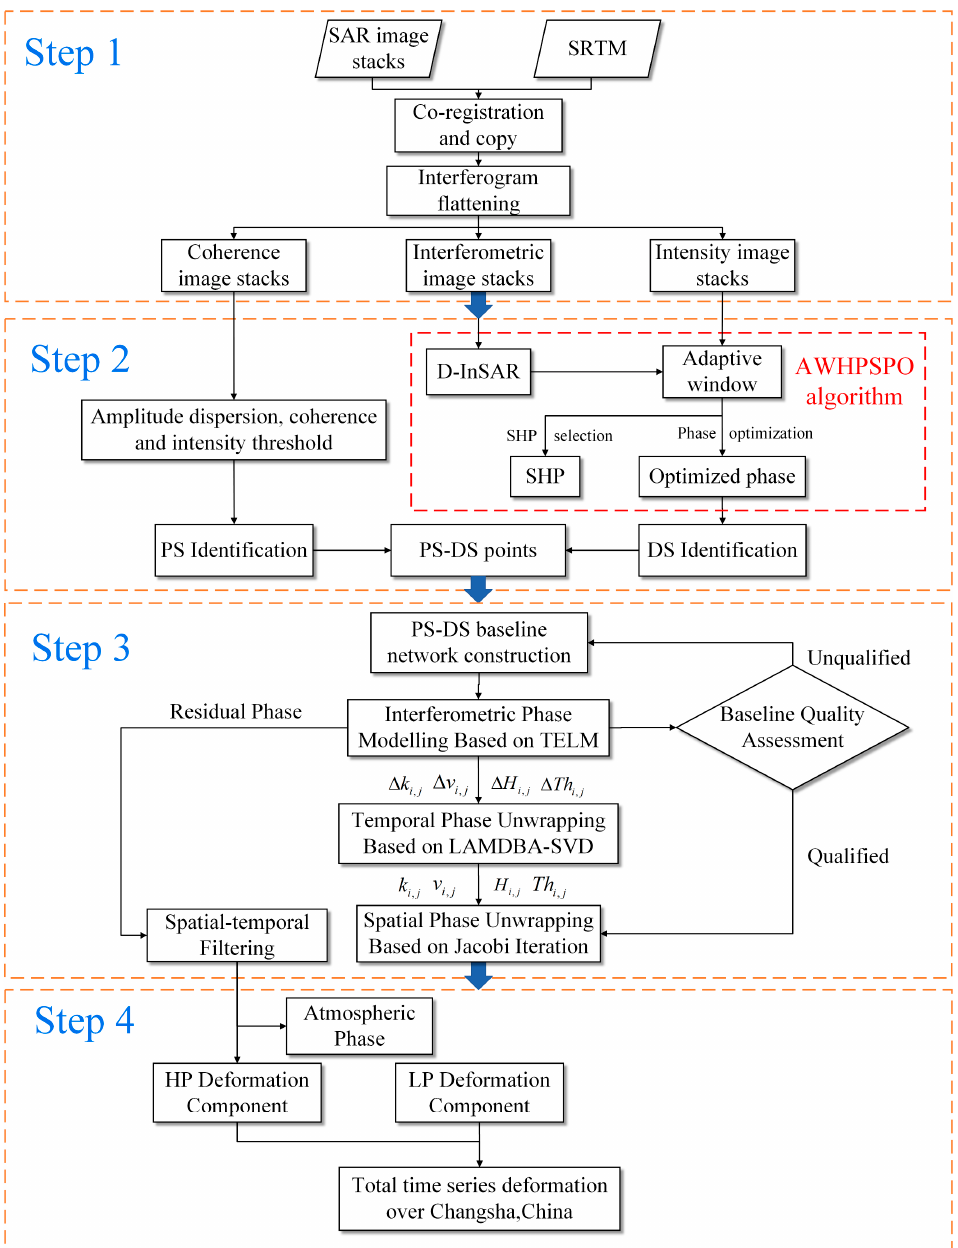
Figure 1. Flow chart of AWHPSPO.